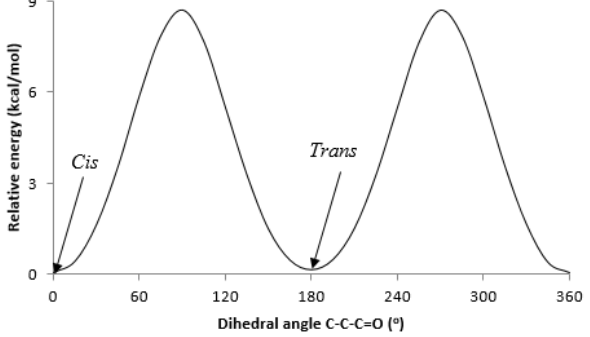
Figure 5. Molecular structures of IIIn series.